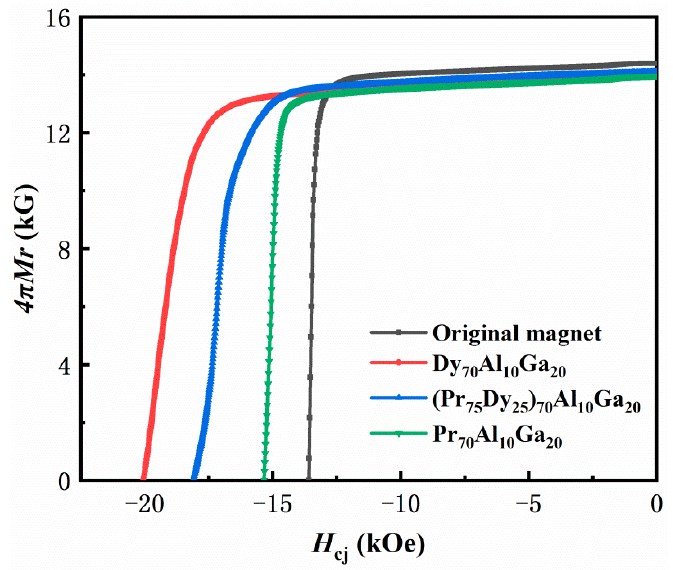
Figure 2. Demagnetization curves of the original magnet and Pr 70 Al 10 Ga 20 , Dy 10 Al 10 Ga 20 and (Pr 75 Dy 25 ) 70 Al 10 Ga 20 diffused